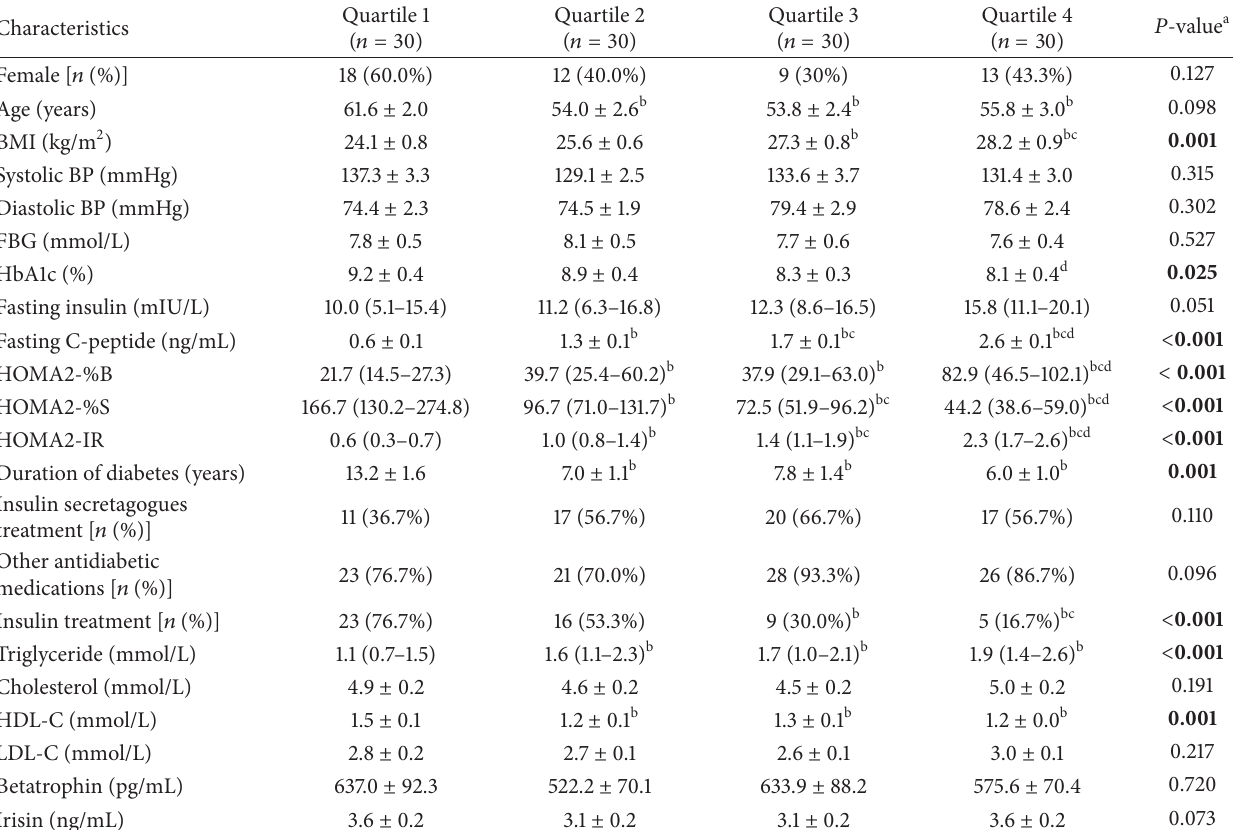
Table 2: Characteristics of the study participants by AUC of C-peptide quartiles in T2DM subjects.